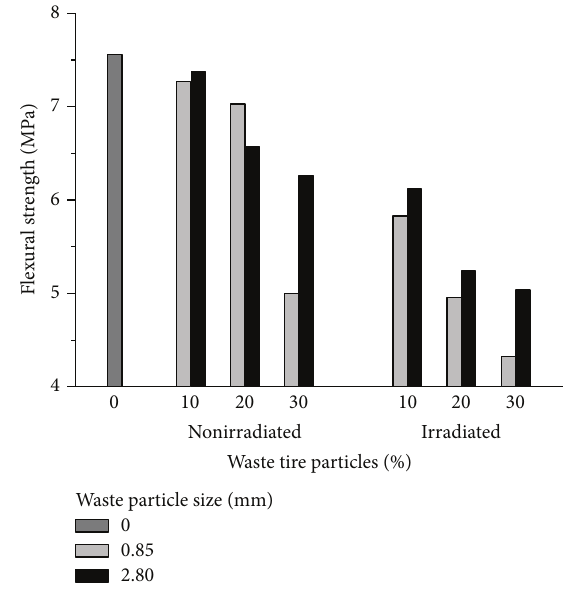
Figure 4: Flexural strength of concrete with waste tire particles.